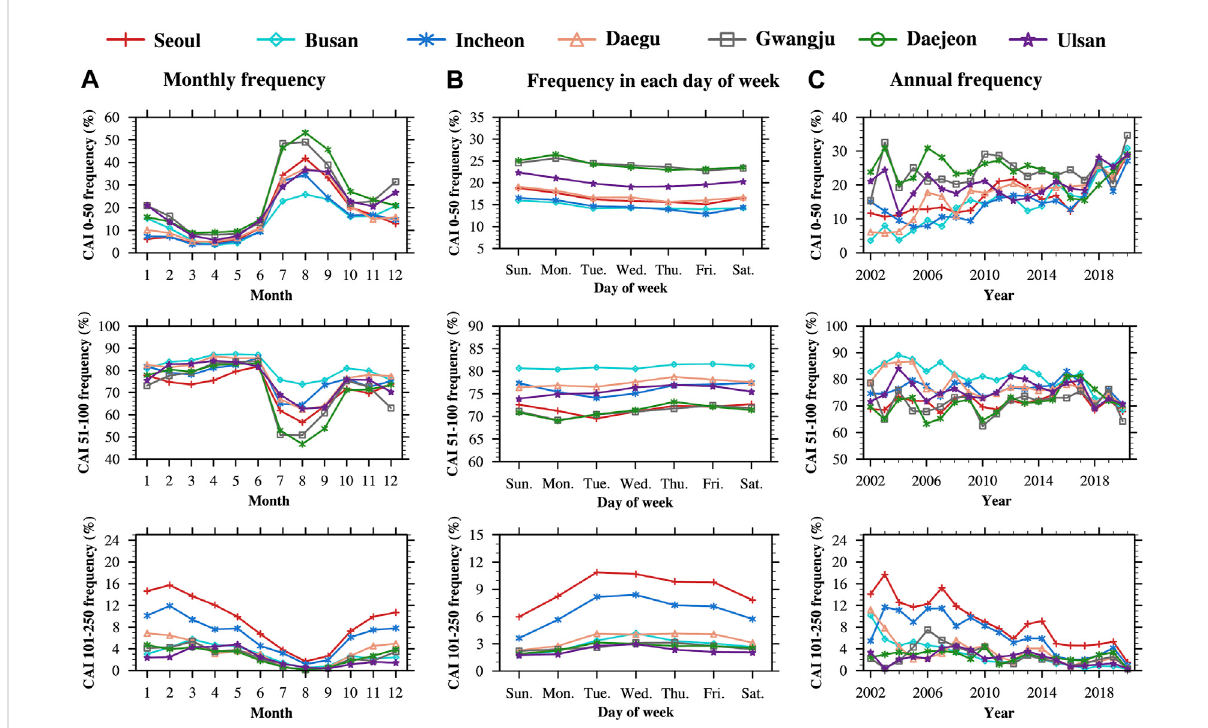
FIGURE 7 During the research period (2002 – 2020), frequency of CAI grades (CAI “ good ” for 0-50, CAI “ moderate for 51 – 100, and CAI “ unhealthy ” for 101 – 250) in multiple time scale: (A) monthly frequency, (B) frequency in each day of week, and (C) annual frequency in seven megacities, South